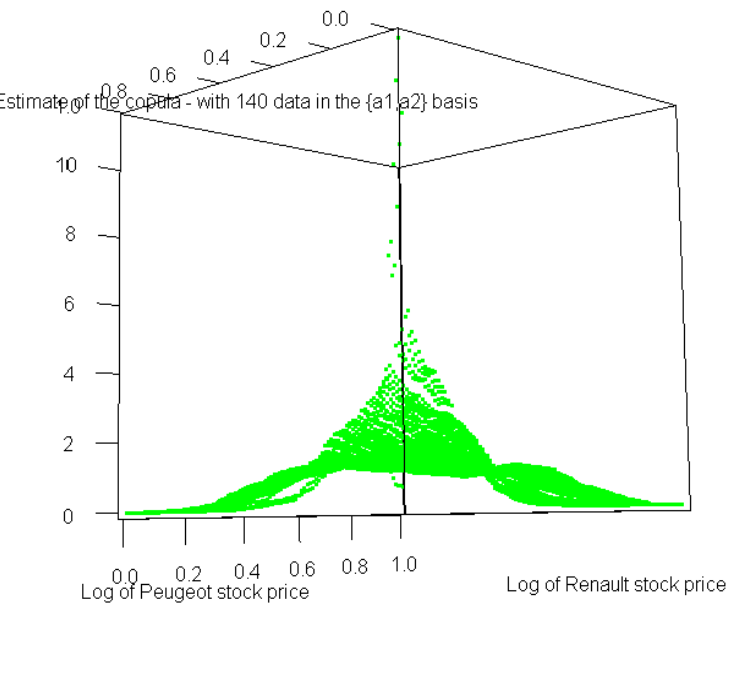
) , ln ( X )) in the { a 1 2